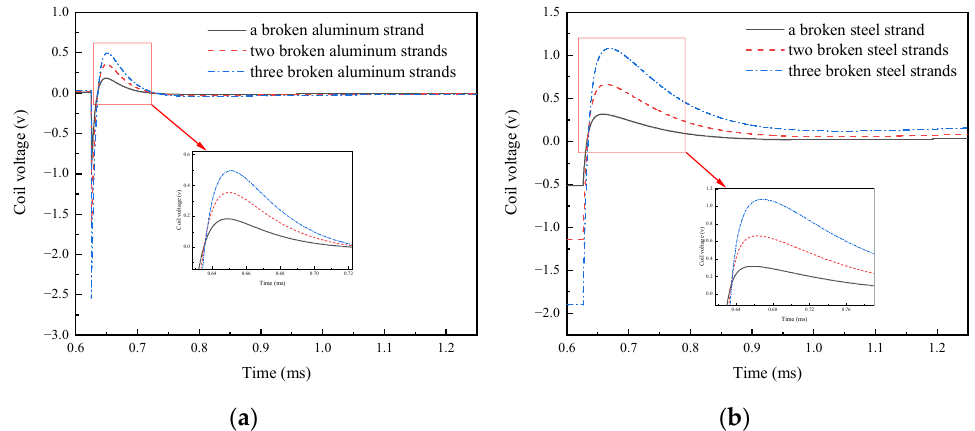
Figure 4. The difference signals of broken strands under different conditions: ( a ) broken aluminum strands; ( b ) broken steel strands.